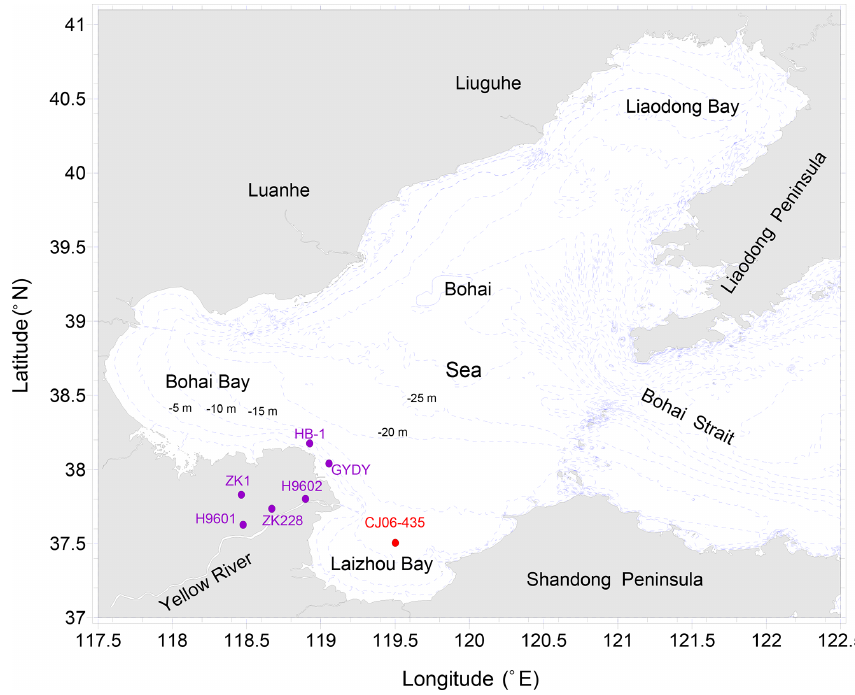
Figure 1. Geographic map of the Bohai Sea, with locations of the core CJ06-435 site (red circle) and other sites referred to in this study (purple circles). Core references are as follows: H9601 and H9602 (Saito et al., 2000), ZK1 (Li et al., 2013), ZK228 (Xue et al.,1988), HB-1 (J. Liu et al., 2009), and GYDY (Liu et al., 2014).